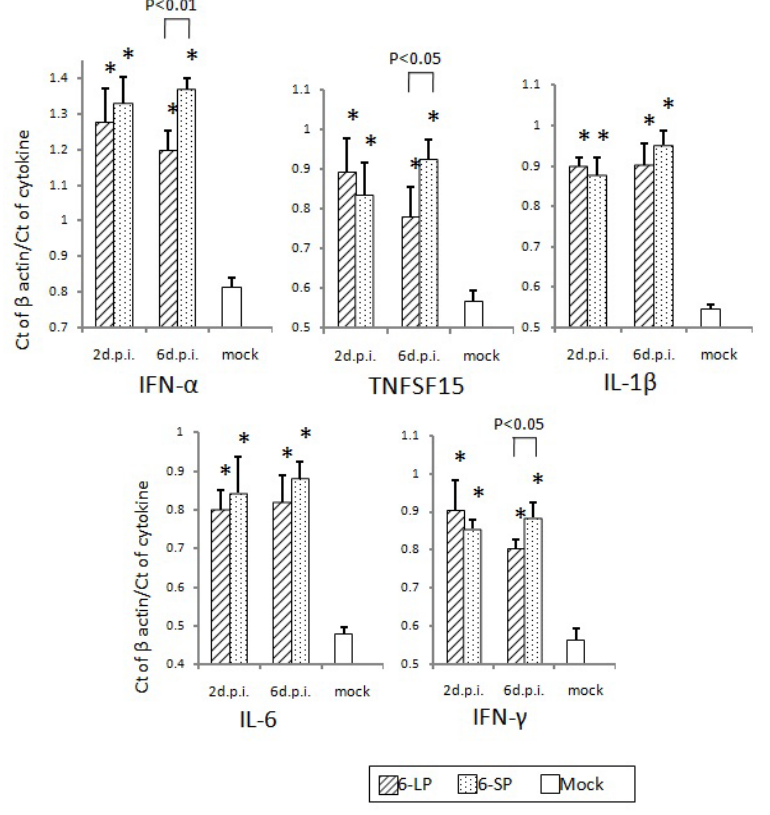
Figure 9. Cytokine and transcription factor mRNA levels in the spleens of 3-week-old chicks inoculated with WNV 6-LP or 6-SP. Chicks were infected with 10 2 PFU subcutaneously (s.c.) in the femoral region, and tissues were collected at 2 and 6 days post infection (d.p.i.). Total RNA was extracted and cDNA synthesized. SYBR Green-based quantitative real-time PCR was performed using the synthesized cDNA. Relative quantification of cytokine gene expression was done using the CT method. The CT data for each cytokine were normalized against the b-actin levels in the same sample. * Statistically significant differences ( p < 0.01) in cytokine and transcription factor mRNA levels compared with mock-infected